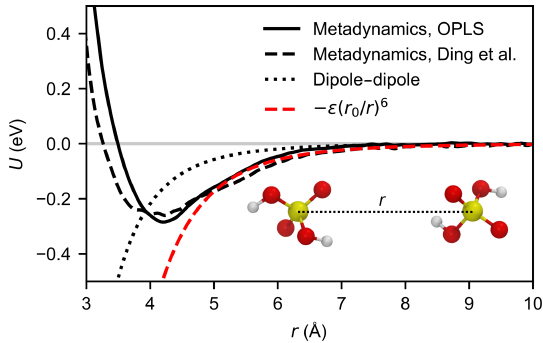
Figure 2. Vibrational spectra of the sulfuric acid molecule obtained with OPLS (Loukonen et al., 2010) (blue area) and the force field by Ding et al. (2003) (orange area). The spectra of Ding et al. (2003) has its highest frequency mode at 6565cm − 1 outside of the range of the figure. The positions of the peaks in the experimental spectra (Hintze et al., 2003; Chackalackal and Stafford, 1966; Miller et al., 2005) and ab initio calculations (Miller et al., 2005) are indicated by dashed and solid grey lines, respectively.